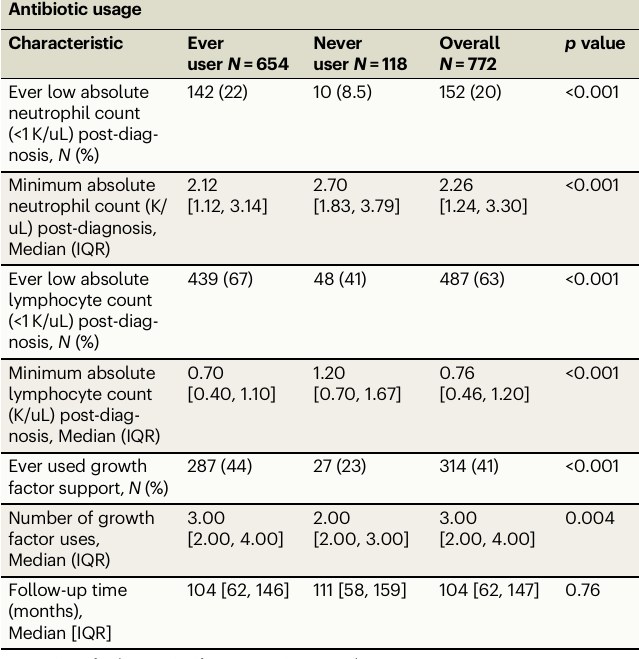
VUS variant ofunknown signi fi cance, IQR interquartilerange. * Bodymass indexwascalculatedas kg/m 2 ,wherekgisweight in kilograms,andm 2 is height in meters squared.Underweightwas categorized as BMIunder 18.5kg/m 2 ; normal asBMI greater thanorequalto18.5to24.9kg/m 2 ;overweightasBMIgreaterthanorequalto25to29.9kg/m 2 ; obeseas BMI greater than orequal to 30kg/m 2 . Two-sided unadjusted p valuesforcomparisonsbetween everandneverusers were derived from Pearson ’ s Chi-squared test,Fisher ’ s exact test, orWilcoxon rank-sum test.